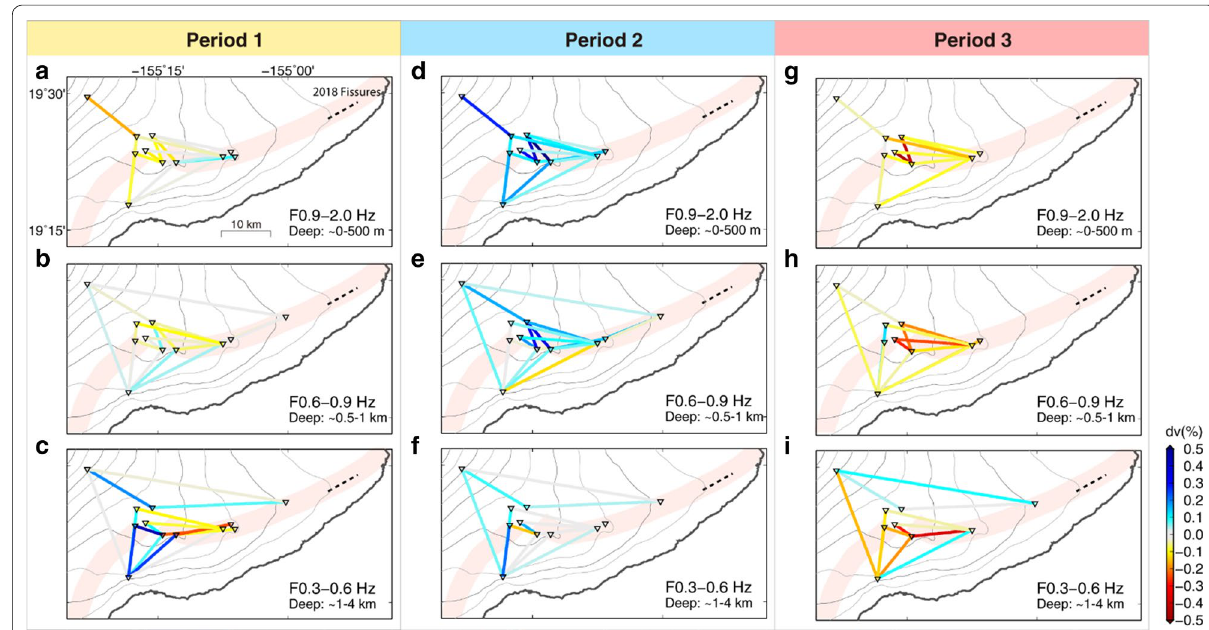
Fig. 8 Map of frequency‑dependent magma‑related d v / v changes in three time periods marked in Fig. 5. a – c Period 1. d – f Period 2. g – i Period 3. In Period 1, the d v / v values are color‑coded by averaging d v / v values between January 1, 2018 and March 15, 2018 (yellowish shaded zone in Fig. 5). In Period 2, the d v / v values are color‑coded by subtracting d v / v value on March 15, 2018 from that on April 17, 2018 (bluish shaded zone in Fig. 5). In Period 3, the d v / v values are color‑coded by subtracting d v / v value on April 17, 2018 from that on May 1, 2018 (reddish shaded zone in Fig. 5). The black dashed line indicates the fissures opened during the 2018